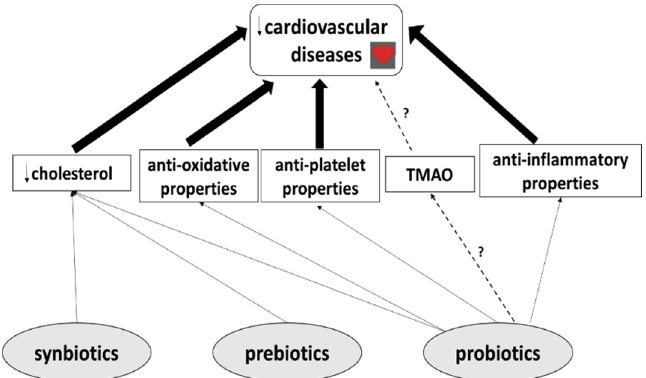
Figure 3. The effect of probiotics, prebiotics and synbiotics on cardiovascular disease. Probiotics lower the level of cholesterol by increasing bile salt synthesis and bile acid deconjugation. Probiotics also have anti-oxidative, anti-platelet and anti-inflammatory properties, and hence may offer protection from cardiovascular diseases. One proposed model of preventing the CVD-induced accumulation of TMAO may be probiotic supplementation. However, prebiotics and synbiotics may also decrease the level of total cholesterol and offer similar protection from cardiovascular disease. More details in